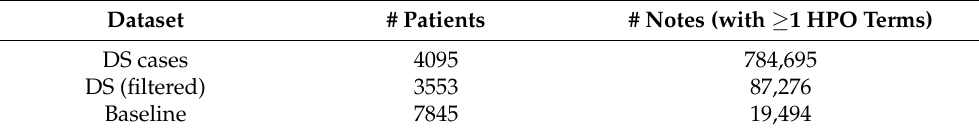
Table 1. Population numbers for Down syndrome and baseline patient cohorts. # This details the number of patients, their notes, and notes after filtering out short and low-quality